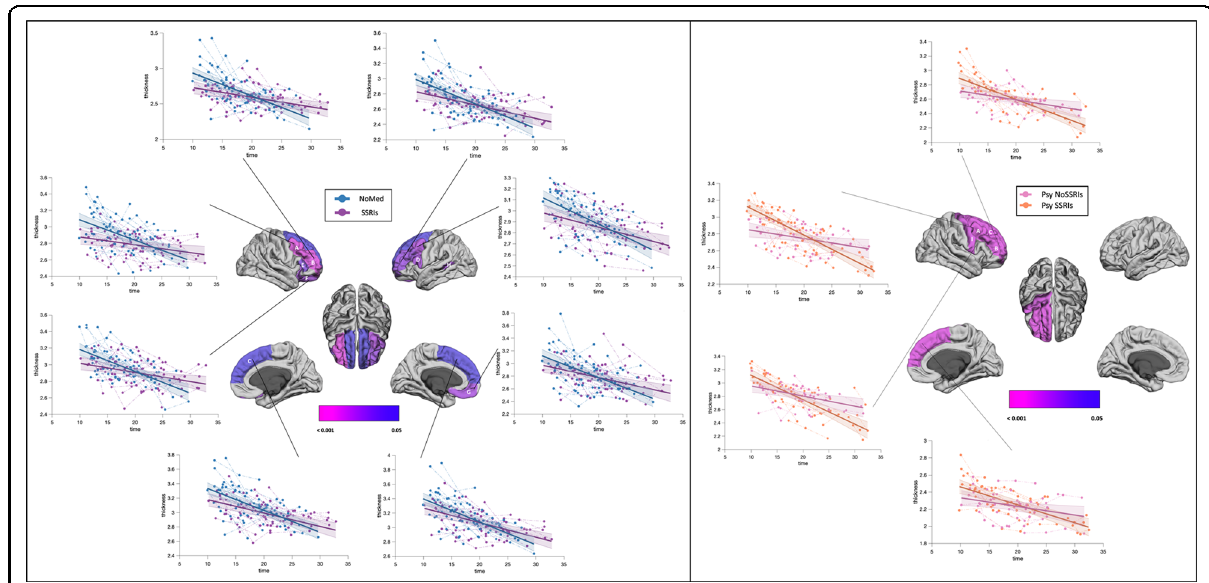
Fig. 3 Cortical thickness trajectories. Developmental trajectories of CT of brain regions with divergent maturation in deletion carriers with and without treatment with SSRIs (left panel) and deletion carriers endorsing psychotic symptoms with and without treatment with SSRIs (right panel)). The brain maps are showing regions all the regions with a statistically FDR-corrected signi fi cant difference in slope (group × age interaction) between the groups. A = Rostral middle frontal, B = Caudal middle frontal left, C = Superior frontal, D = Pars opercularis, E = Pars triangularis, F = Pars orbitalis, G = lateral orbitofrontal, H = Superior temporal